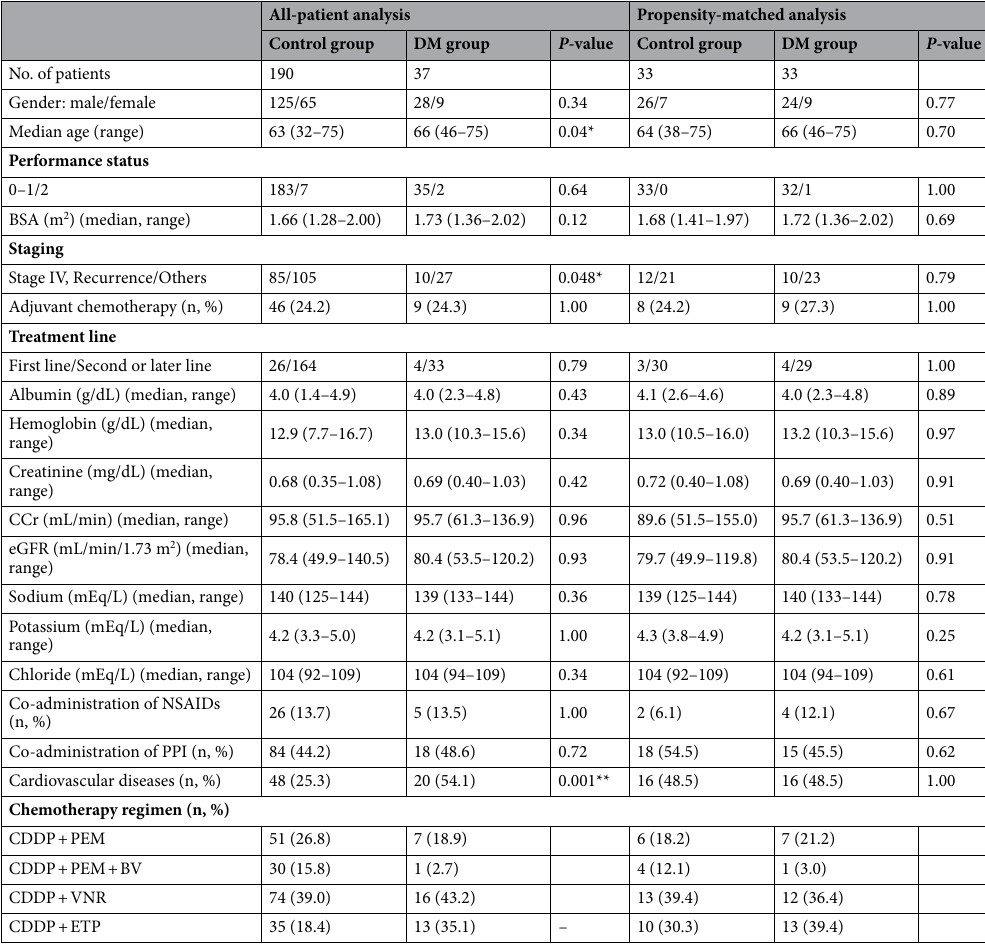
Table 1. Patient characteristics for all patients and propensity-matched patients. * P < 0.05; ** P < 0.01. DM diabetes mellitus, BSA body surface area, CCr creatinine clearance, eGFR estimated glomerular filtration